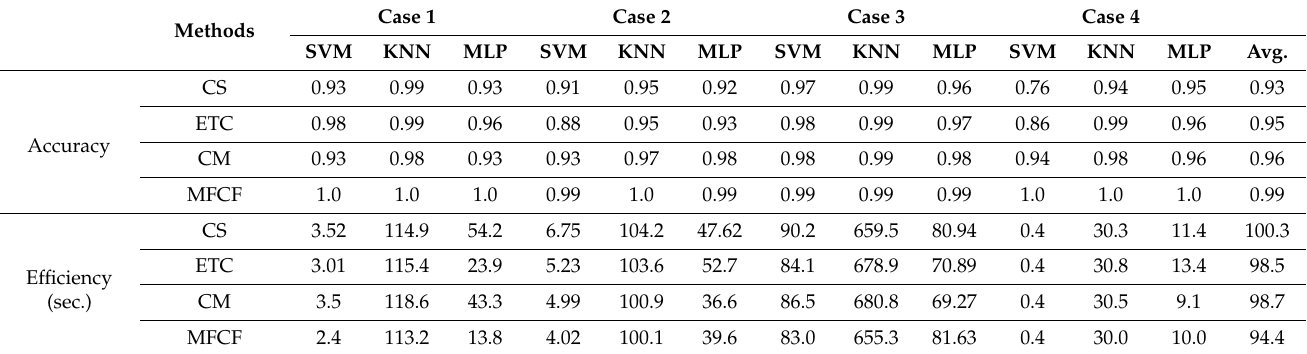
Table 5. Accuracy and execution times with the test